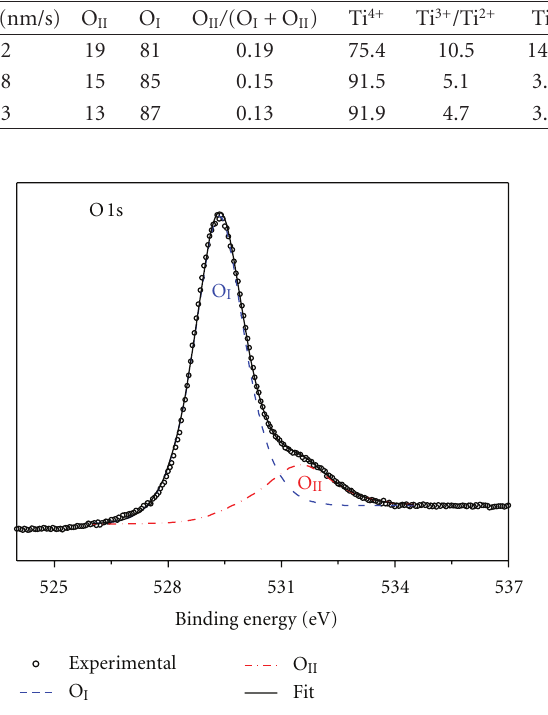
Figure 7: Fit of Ti 2p XPS spectrum for thin films of TiO 2 − y obtained at (a) S d = 1 . 82 nm/s and (b) S d = 0 . 23 nm/s. Three components of each fit 1, 2, 3 correspond to di ff erent oxidation states of titanium.